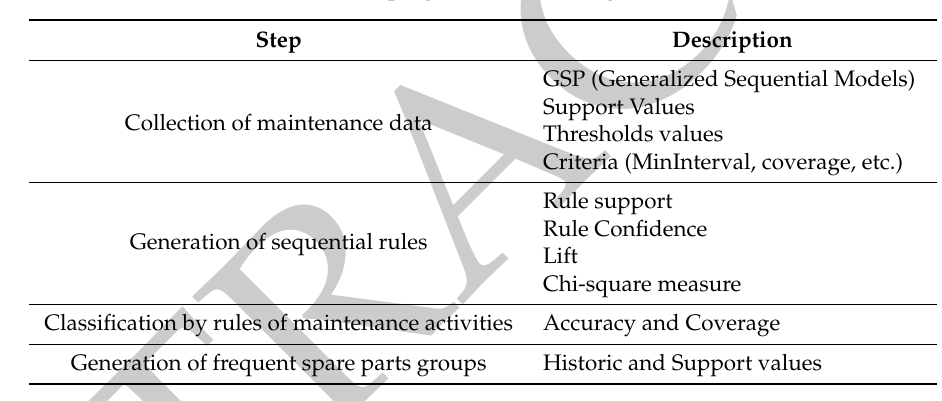
Table 6. The progress of our solving